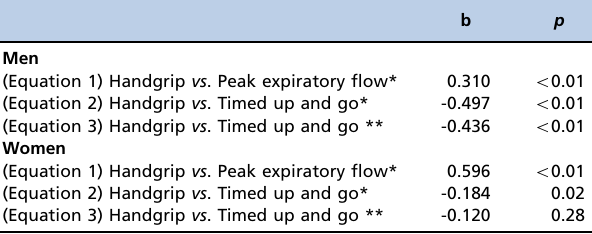
Table 2 - Linear regression between handgrip strength, peak expiratory flow and timed up and go performance in men and women.